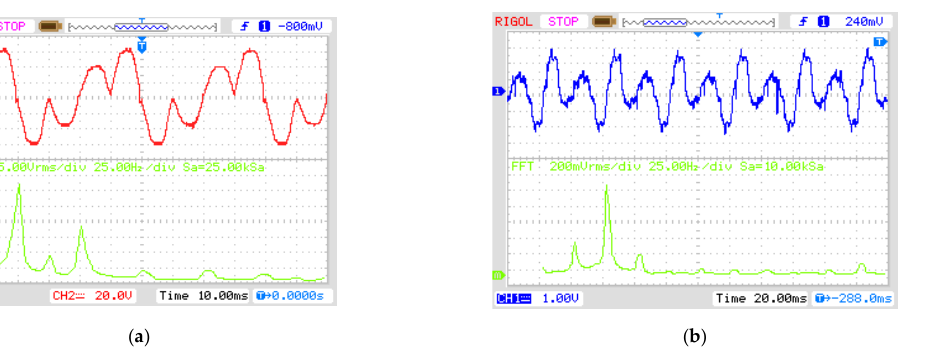
Figure 15. Practically recorded results for one-half output frequency with pulse voltage regulation capabilities: ( a ) output voltage and its FFT spectrum; ( b ) input current and its FFT spectrum.